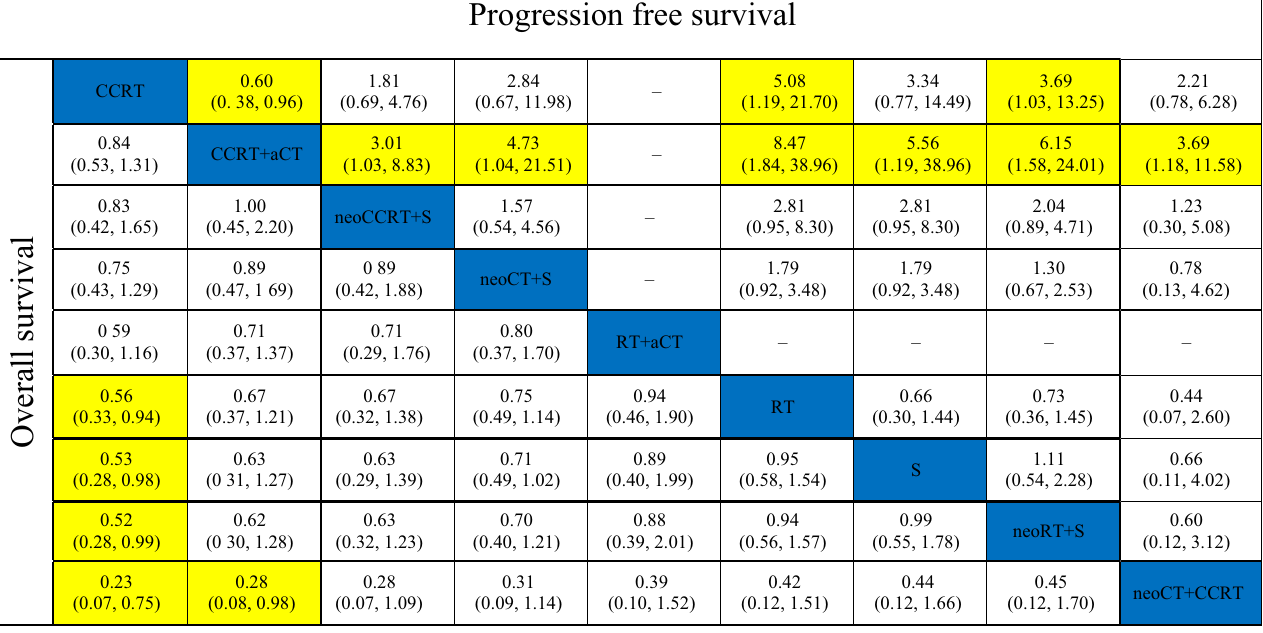
TABLE 2 | Pooled estimates for the overall survival and progression free